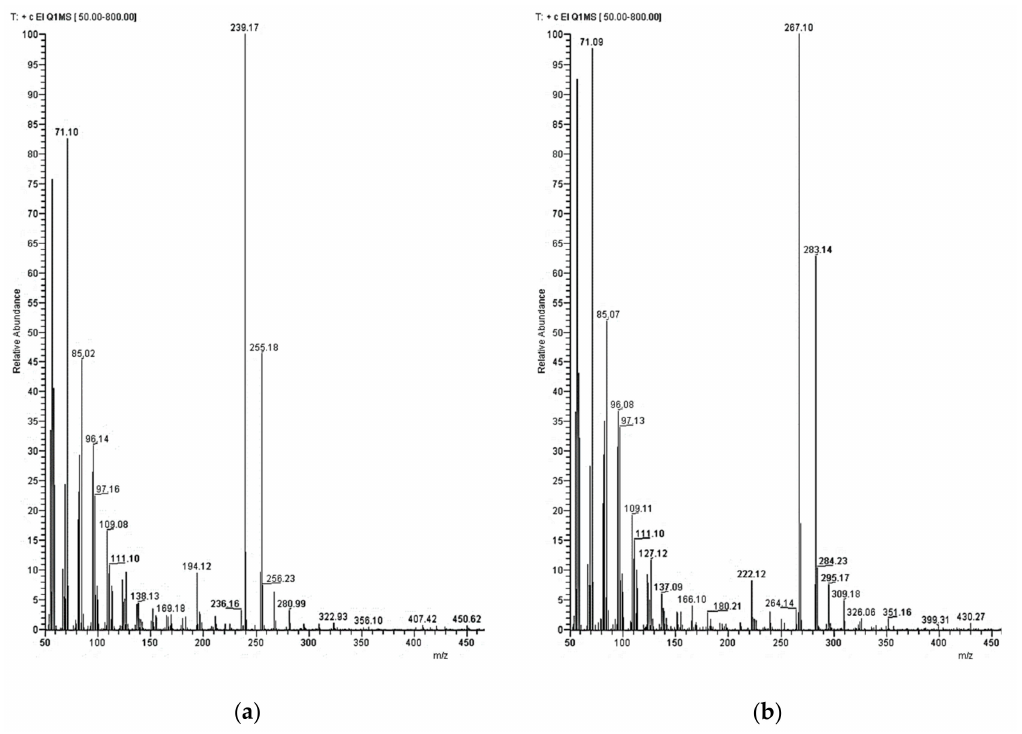
Figure 6. EI mass spectra of palmitone ( a ) and stearone ( b